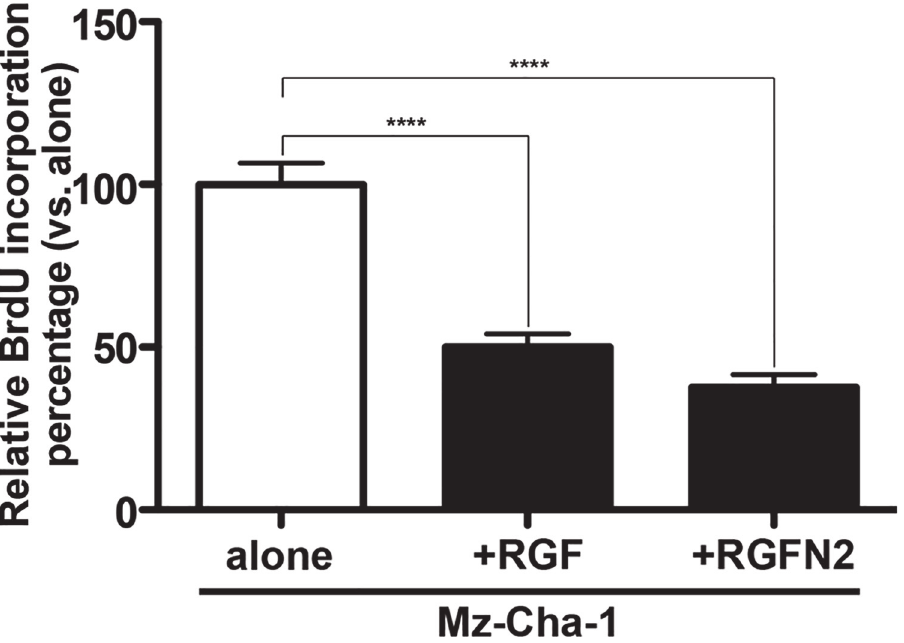
Fig 5. Co-culture of Mz-Cha-1 cholangiocytes with immortalized rat portal fibroblastic RGF and RGF-N2 cell lines by bromodeoxyuridine incorporation assay. Sub-confluent immortalized human Mz- Cha-1 cholangiocytes were labeled with bromodeoxyuridine reagent for 24 hours (day 1), and co-cultured with RGF and RGF-N2 cells for additional 24 hours (day 2), before assessment of bromodeoxyuridine incorporation. Both RGF ( **** + RGF : M = 50 . 11 , SE = 3 . 899 , vs . alone : M = 100 , SE = 22 . 76 , p < . 0001 , n = 4) and RGF-N2 ( **** +RGF-N2 : M = 37 . 64 , SE = 13 . 40 vs . alone : M = 100 , SE = 22 . 76 , p < . 0001 , n = 4) cell lines are able to inhibit proliferation of